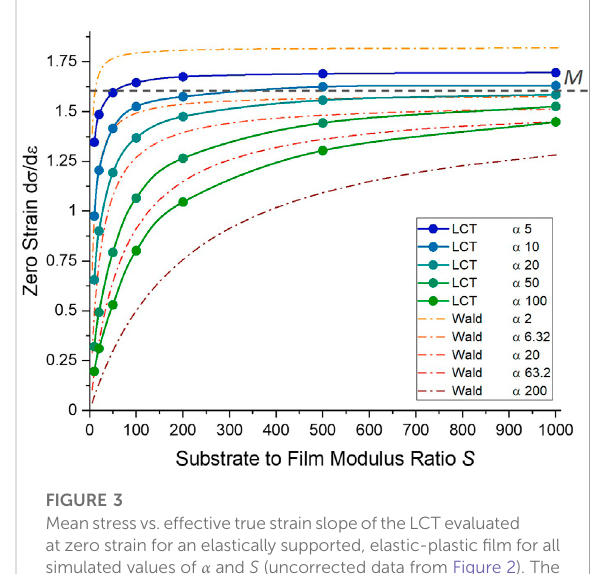
FIGURE 3 Meanstressvs.effectivetruestrainslopeoftheLCTevaluated at zero strain for an elastically supported, elastic-plastic fi lm for all simulated values of α and S (uncorrected data from Figure 2). The theoretical con fi ned modulus M = 1.6 GPa for the fi lm material under uniaxial strain is shown by a dotted line. For each aspect ratio there exists a critical value of S such that the slope ceases to vary rapidly and has close to constant offset from M . The results of Wald et al. (Wald et al., 2013) using Eq. 8 are plotted as dashed lines and show excellent agreement for eg. the case of α =